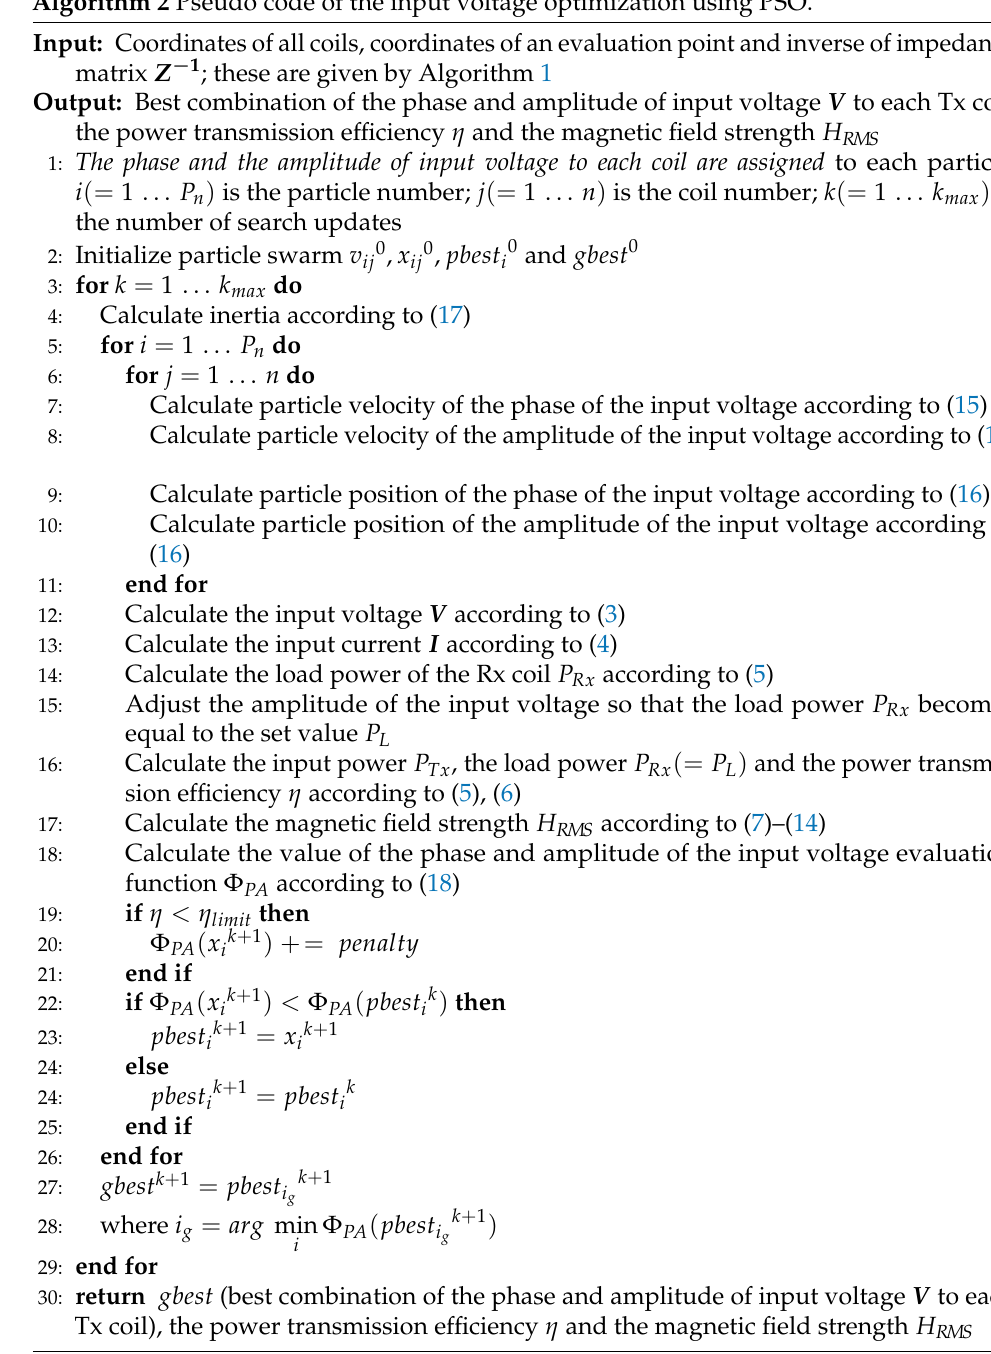
Algorithm 2 Pseudo code of the input voltage optimization using